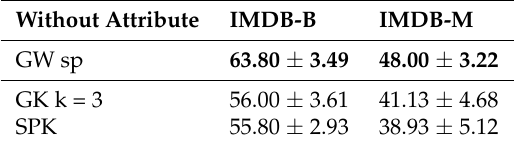
Table 3. Average classification accuracy on the graph datasets with no attributes. Without